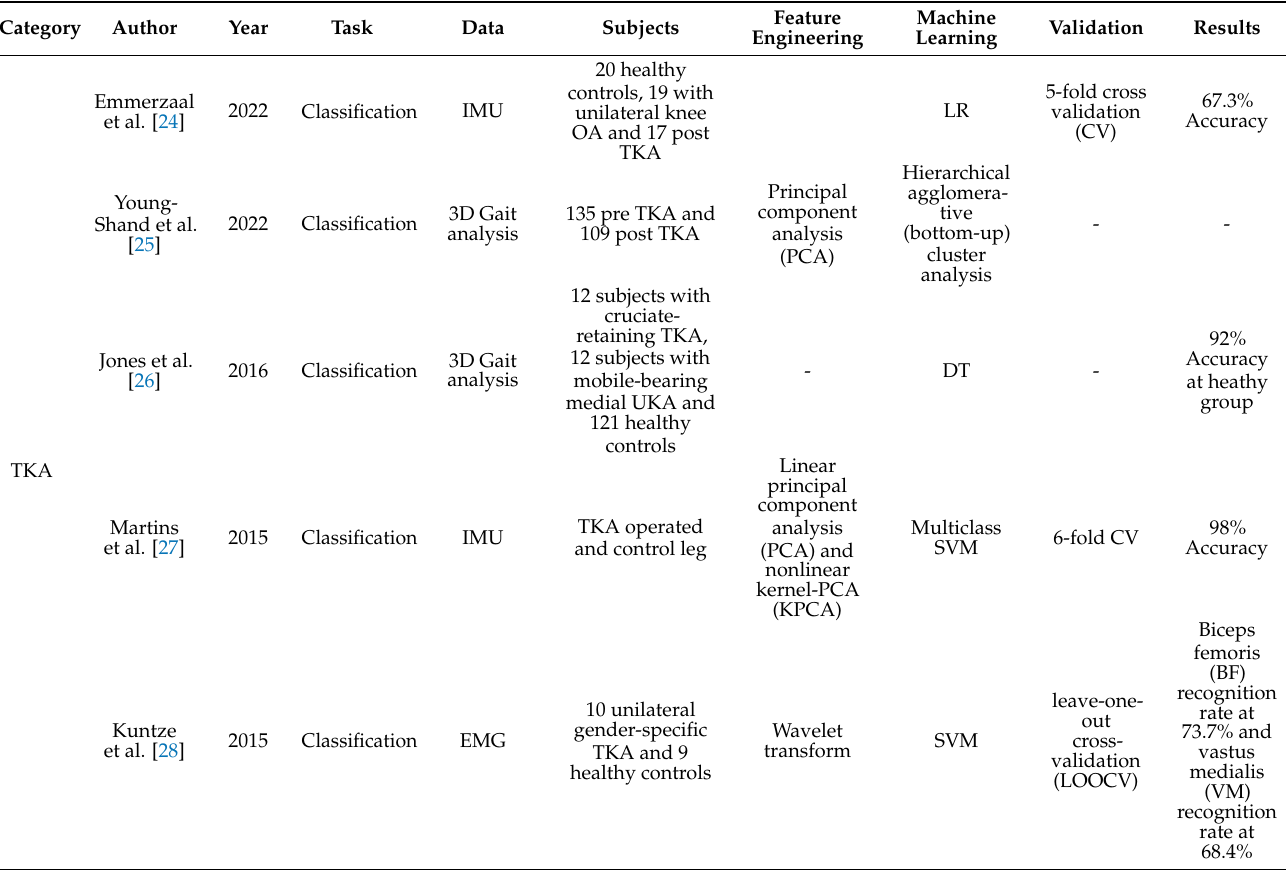
Table 3. Results of the employed studies.